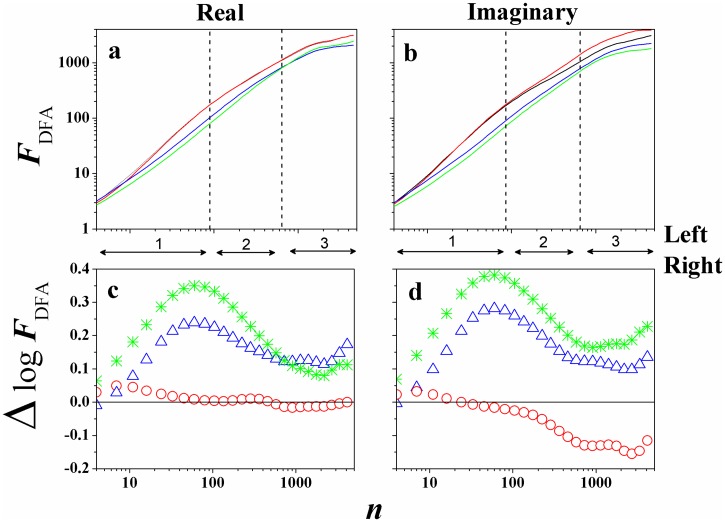
(Color on-line) FDFA in function of n for S020 experiment 1 for (Left/Right): (a) Real and (b) Imaginary case. Black line represents F332, red line F637, blue line P349, and green line P654. Also, the figures below show the difference ΔlogF32;xx, defined by Eq 2, between the channels for the above function FDFA: (c) Real and (d) Imaginary case. Here, ΔlogF32;37 (∘), ΔlogF32;49 (△), and ΔlogF32;54 (*).